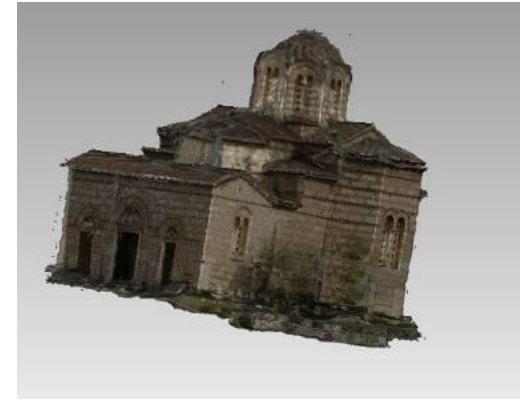
Figure 7: Holy Apostles Church